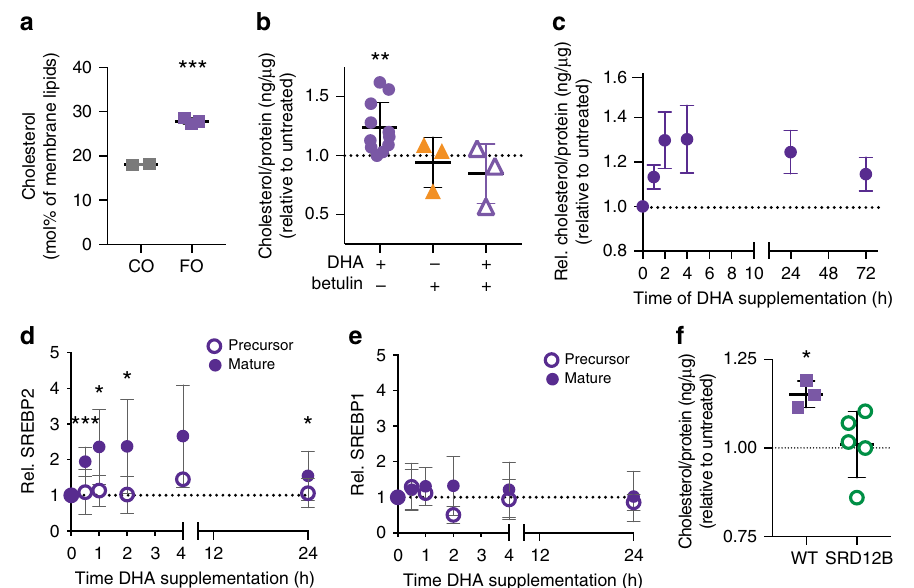
Fig 4 Cholesterol upregulation by DHA supplementation. a Cholesterol levels are higher in membranes isolated from murine heart tissue after feeding with FO compared to CO. b Membrane cholesterol is signi fi cantly increased by DHA supplementation of cultured RBLs. Effect is abrogated by simultaneous treatment with 200 nM betulin. c Time course suggests cholesterol increase is a rapid response to DHA-mediated membrane perturbation. d The “ mature ” , transcription-competent form of SREBP2 is rapidly produced in response to DHA supplementation; n > 6. e SREBP1 proteolytic processing is not signi fi cantly affected by DHA supplementation; n = 4. f Cholesterol is signi fi cantly increased in WT CHO cells treated with DHA; this effect is abrogated in cells with a defect in SREBP activation (SRD12B; S1P-negative). All data shown are average ±SD for n ≥ 3 biological replicates; *** p < 0.001 in ( a ) is one- sample t test between groups; * p < 0.05, ** p < 0.01, *** p < 0.001 in ( b ), ( d ), and ( f ) are one-sample t tests compared to untreated. Full representative Western blots shown in Supplementary Fig. 6. Source data are provided as a Source Data fi